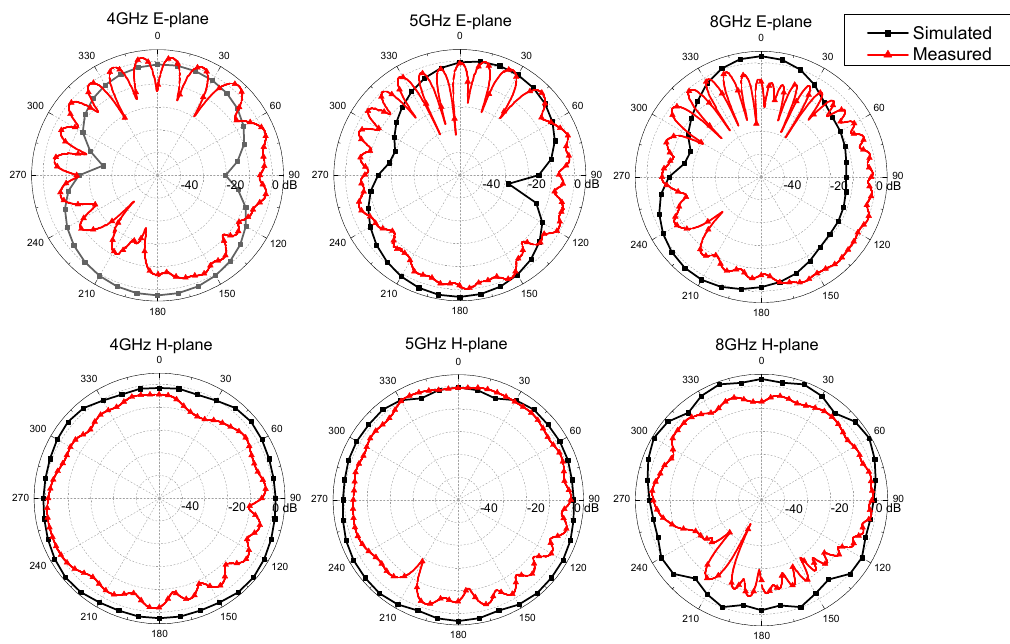
Figure 4. The simulated and measured radiation patterns of the proposed antenna.